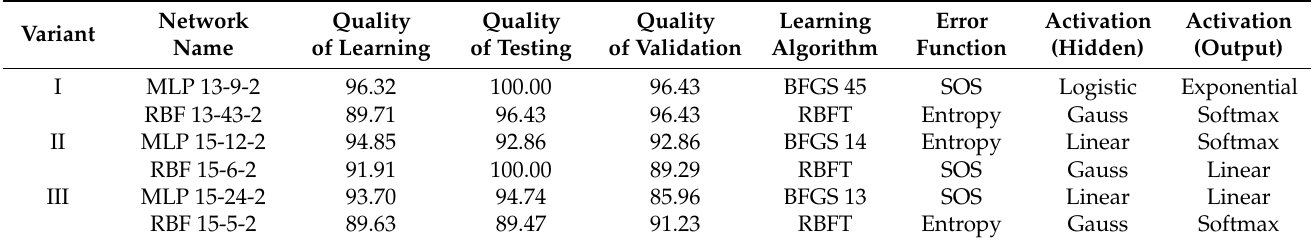
Table 2. Quality of the MLP and RBF neural network for variant I (open kinetic chain), II (close kinetic chain) and III (open and close kinetic